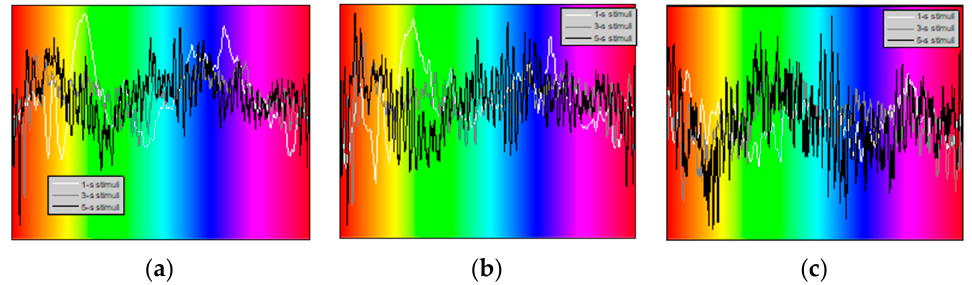
Figure 3. Visual evoked potentials for the “1-s”, “3-s”, and “5-s” stimuli and Oz ( a ), POz ( b ), and Cz ( c ) EEG channels.